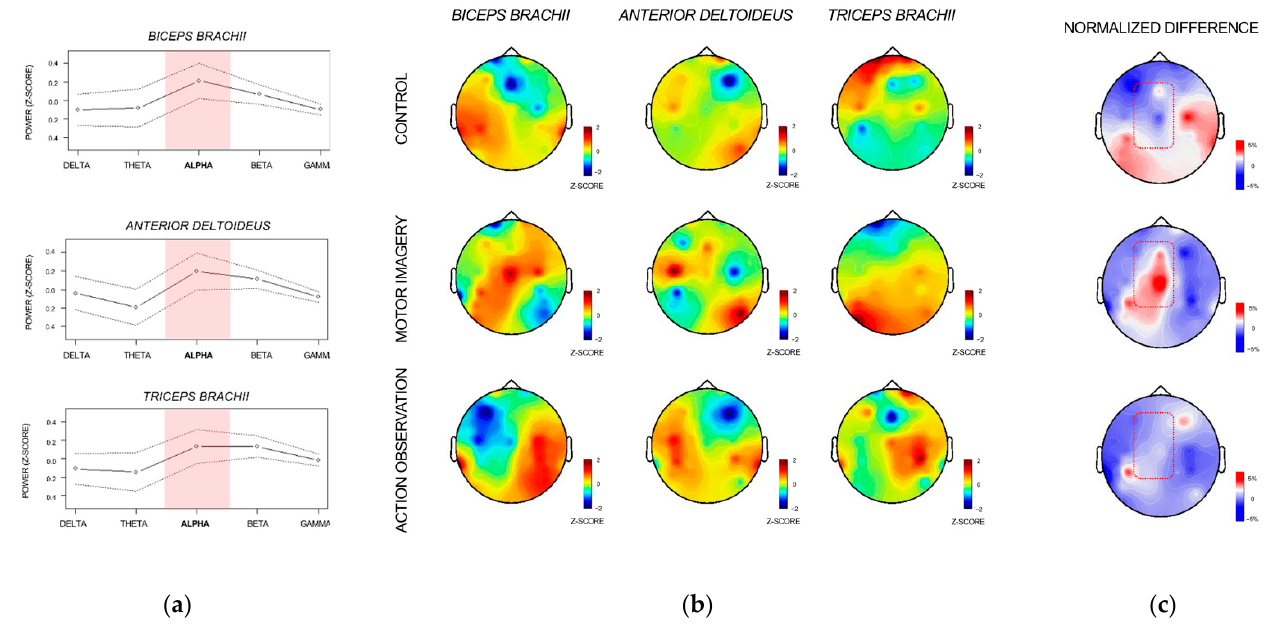
Figure 3. Corticomotor coherence analysis during isometric muscle contraction. ( a ) Standardized coherence power spectrum across frequencies bands for each muscle averaged across experimental conditions presented with 95% confidence intervals (dotted lines); ( b ) imaginary coherence topographies for the alpha (8–12 Hz) frequency range in the EEG sensors-space for all muscles and experimental conditions; ( c ) CMC RATIO topographies used as connectivity indexes of agonist/antagonist corticomuscular connectivity across experimental conditions.